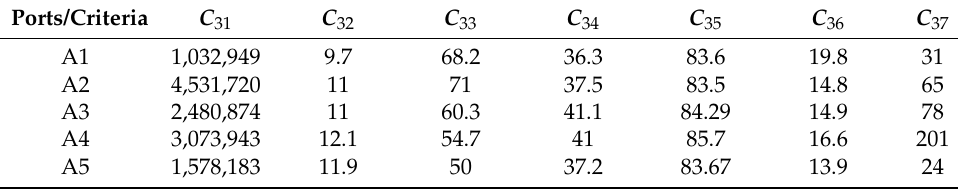
Table 6. Decision matrix for social criteria.